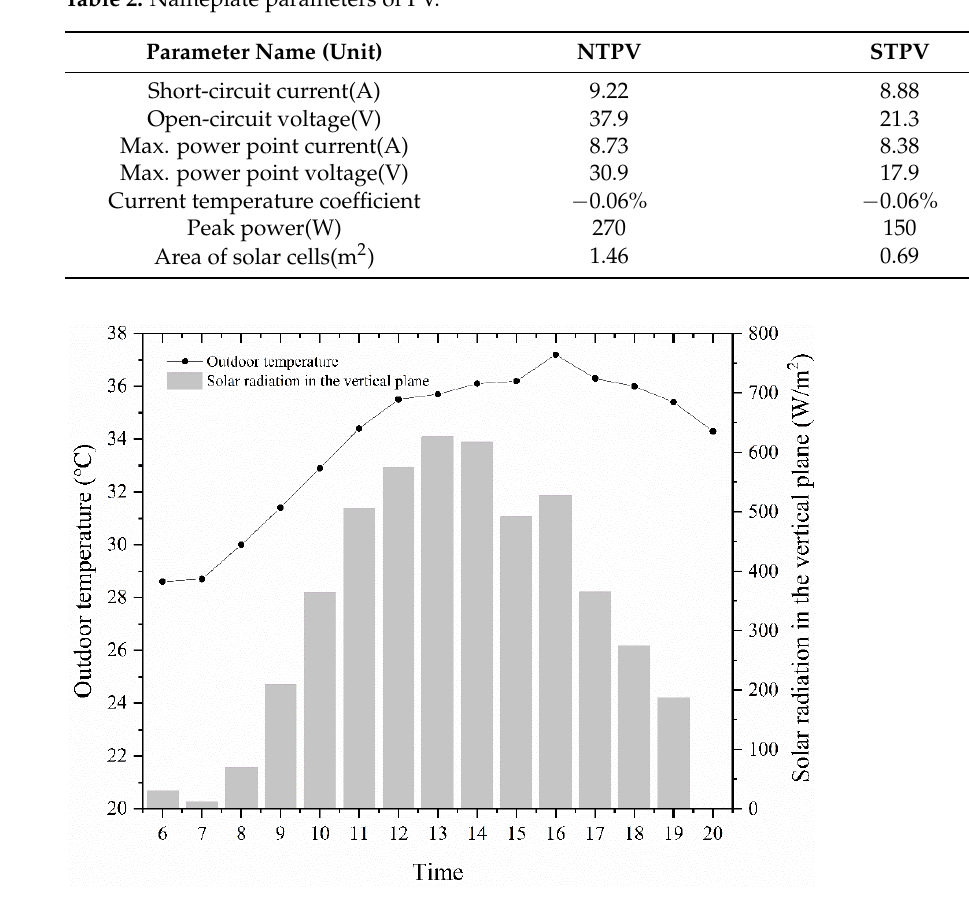
Table 2. Nameplate parameters of PV.